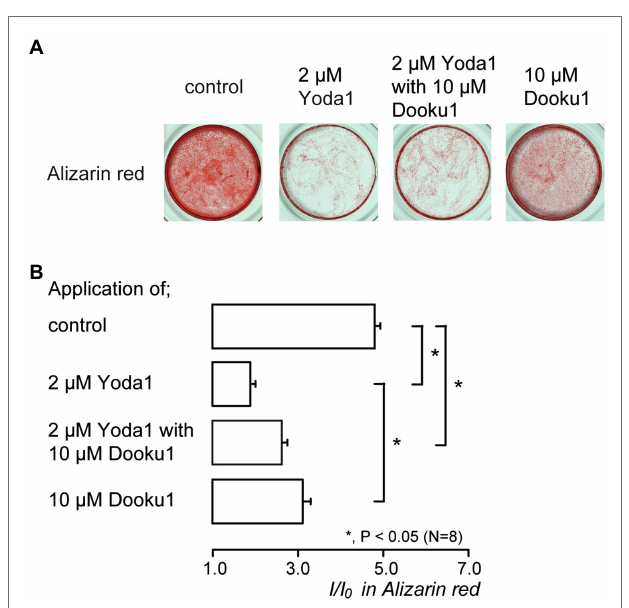
FIGURE 5 | Piezo1 channel knockdown by gene silencing with short hairpin RNA (shRNA) reduced the functional expression of Piezo1 not Piezo2 channels. (A–D) Immunoreactivity to the Piezo1 channels (green in A,C ) or the Piezo2 channels (red in B,D ) in human odontoblasts transfected by shRNA including a vector specific for human Piezo1 (C,D) , or including an empty vector control (A,B) . Nuclei are shown in blue. Scale bar: 100 μ m. No fluorescence was detected in the negative controls (not shown). (E) Bar graph showing the percentage area of the Piezo1 channel-immunopositive cells (%; green columns), and those of Piezo2 channel- immunopositive cells (%; red columns) in immunofluorescence analysis from human odontoblasts transfected by shRNA including a vector specific for human Piezo1 (second left and most right columns), or including an empty vector control (most left and third left). Each bar indicates the mean ± SD of five experiments. (F) Representative traces of transient increases in [Ca 2+ ] i during mechanical stimulations induced by vertical micropipette displacement downward by 8.0 μ m (black boxes at the top) in standard extracellular solution in cells transfected by shRNA including a vector specific for human Piezo1 (shRNA-Piezo1 transfected), or including an empty vector control (shRNA-Control transfected). (G) Bar graph of the values of [Ca 2+ ] i increases induced by mechanical stimulation (8.0 μ m) in cells transfected by shRNA including a vector specific for human Piezo1 (gray column), or including an empty vector control (open column). The resting value is shown as F / F 0 = 1.0. The numbers in parentheses indicate the number of cells tested. Asterisks denote statistically significant differences between columns (shown by solid line in G): * p < 0.05; N.S., not significant.